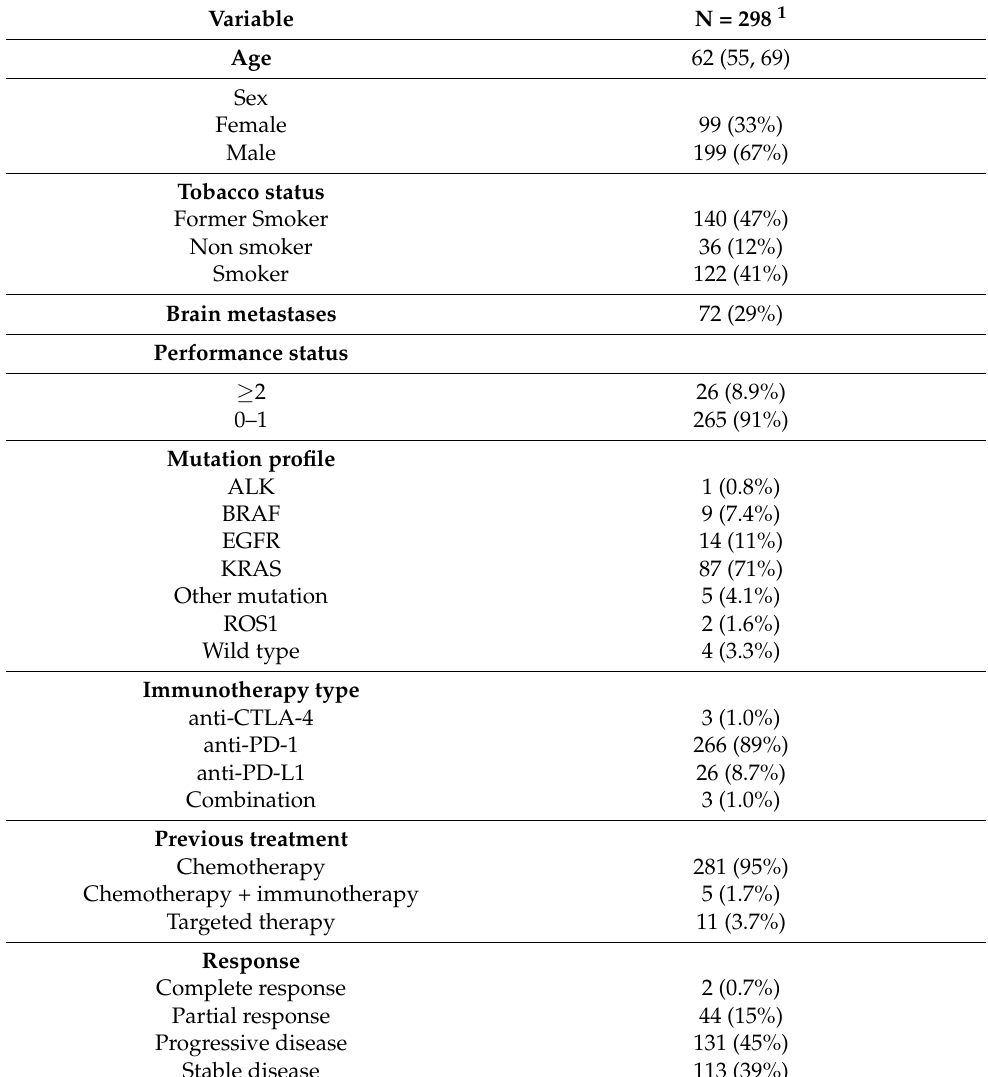
Table 1. Patients and disease